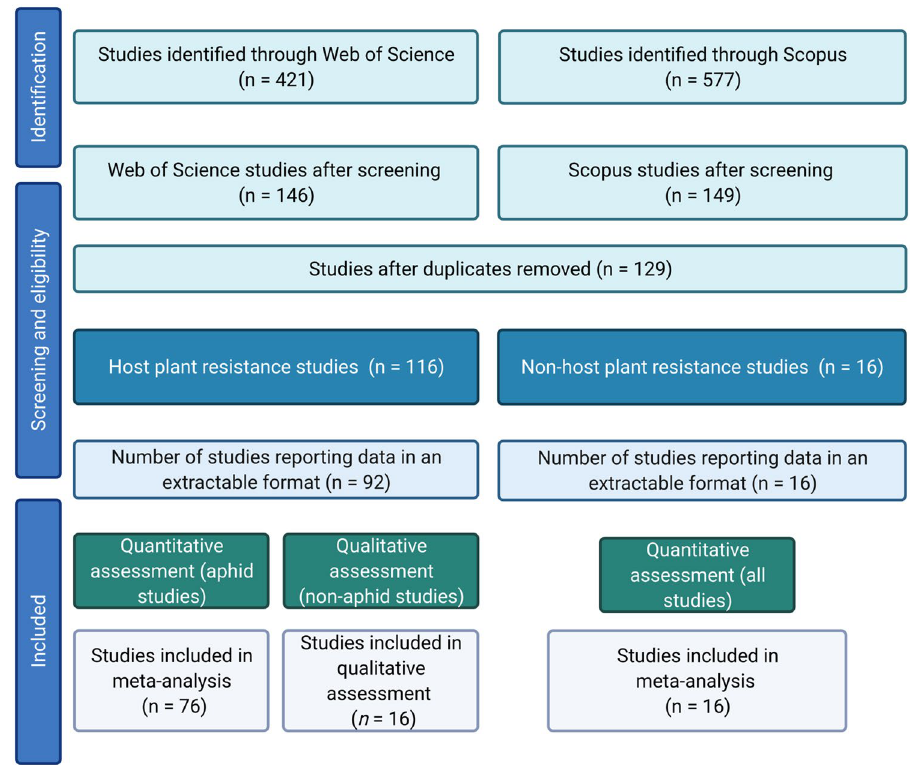
Figure 6. PRISMA diagram. This image was created with